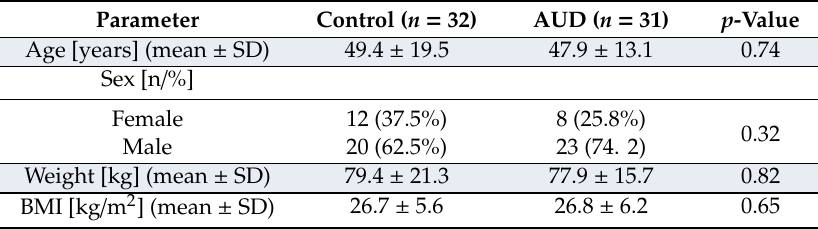
Table 1. Demographic characteristic of studied subjects enrolled in this study.